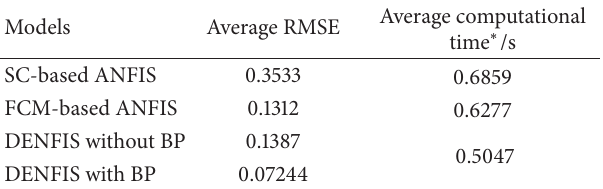
Table 5: Test performance of the NF models (handiness).